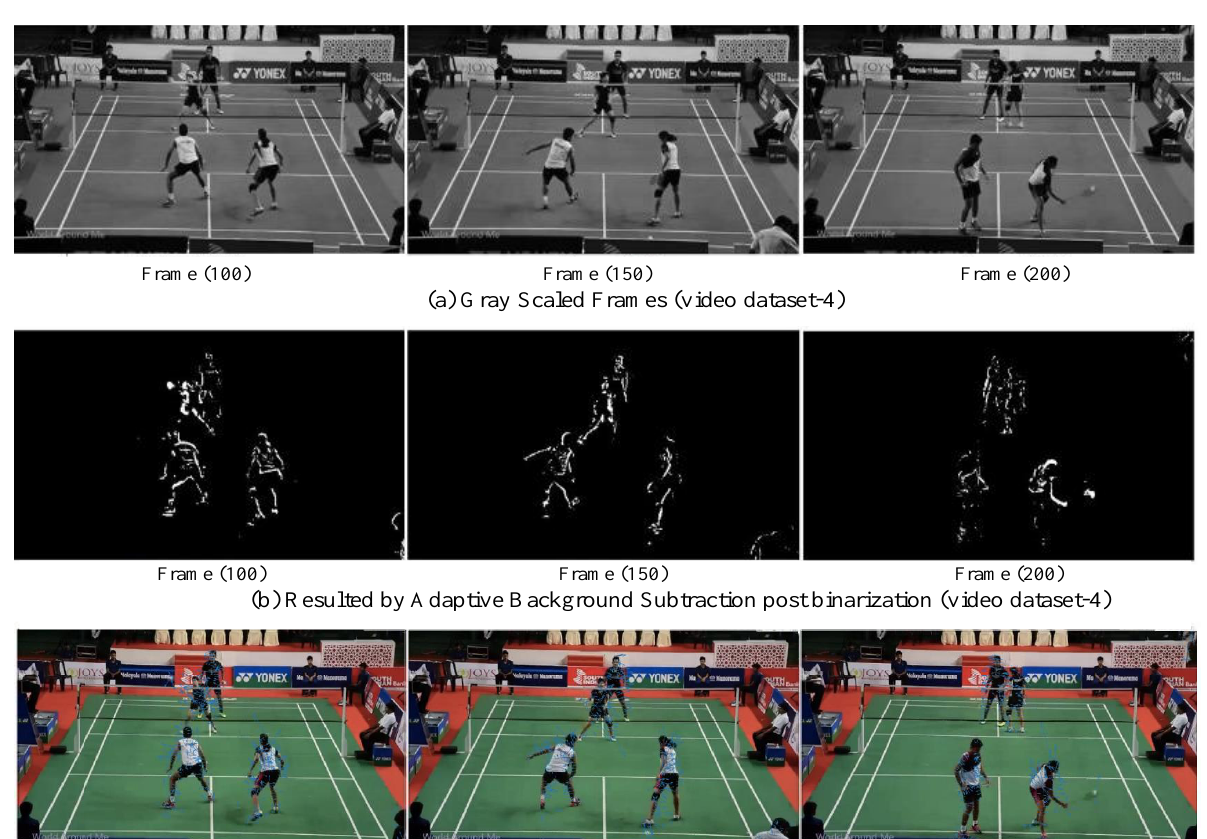
Figure 9. Activity map and pixel sensitivity maps of video dataset 3 by different approaches: ( A ) by Pan et al. in [12]; ( B ) by Mehboob et al. in [13]; ( C ) by Indu, S. in [14]; ( D ) our proposed framework. D. Video dataset 4 (Sports — Badminton):